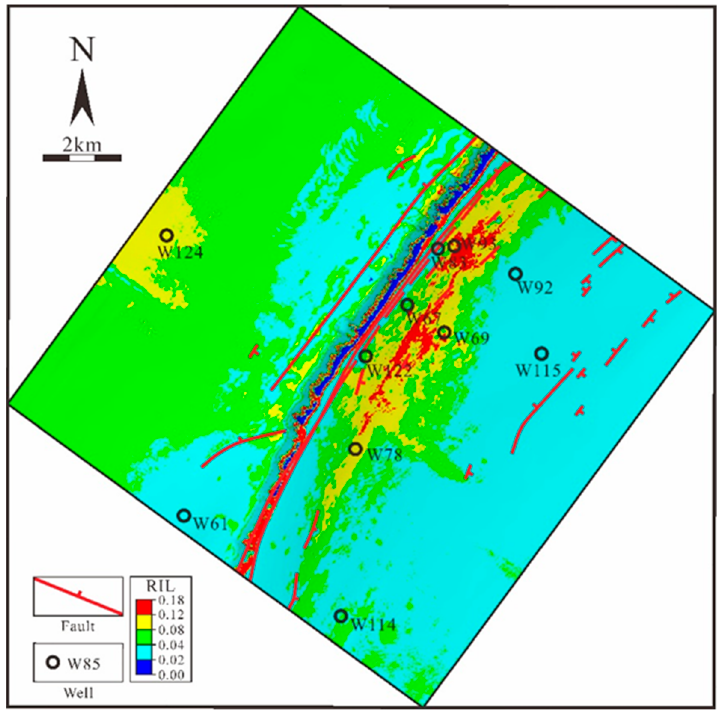
Figure 15. Plane prediction of RIL reservoir indicator factor attributes.